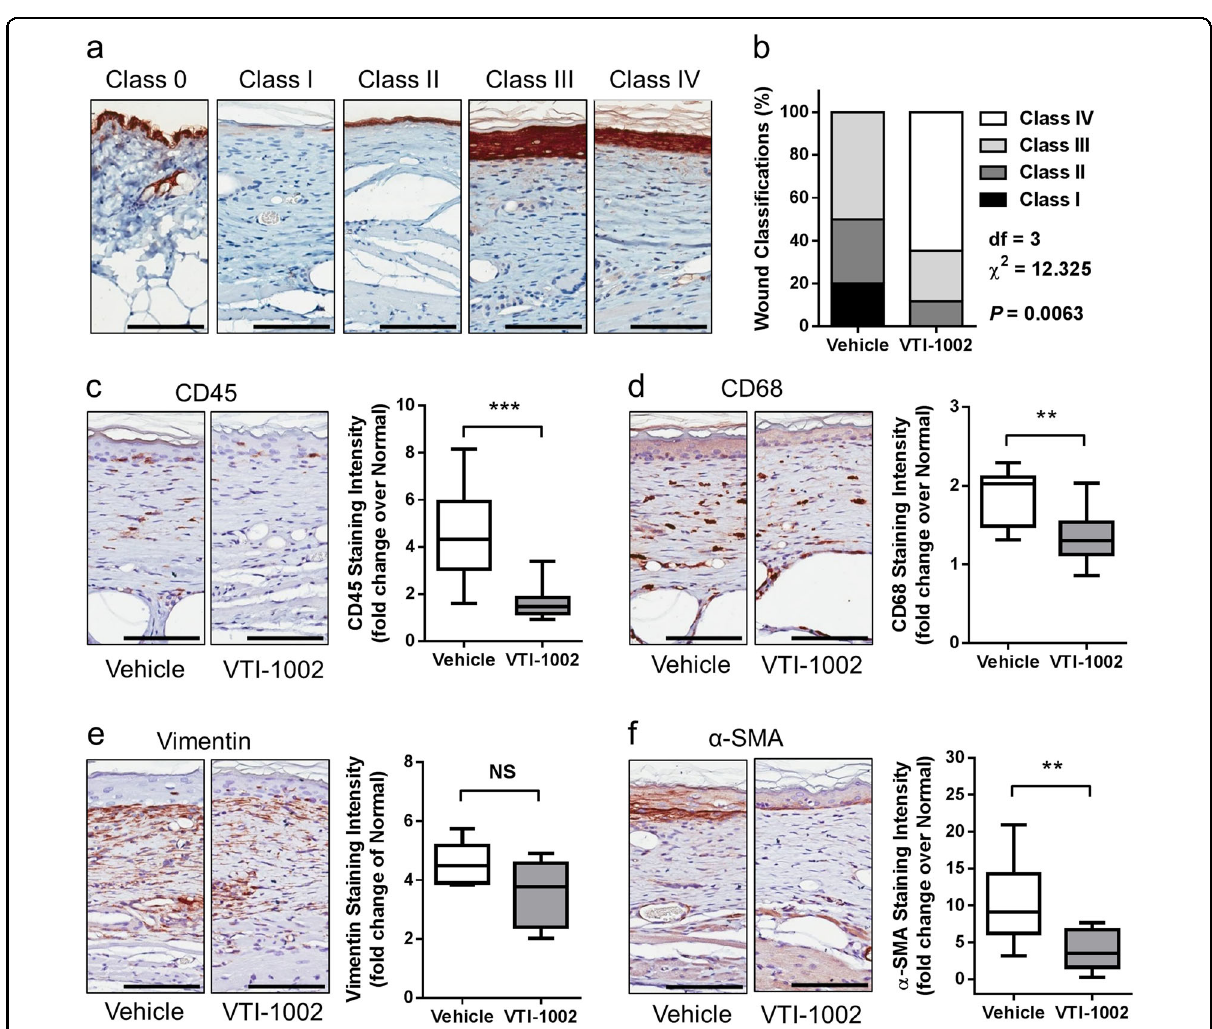
Fig. 2 Topical application of VTI-1002 gel accelerates re-epithelialization and wound maturation in diabetic burn wounds. a Representative morphology of different wound classes (IHC keratin staining). b Prevalence of wound class in vehicle control group ( n = 10) and VTI-1002 treatment group ( n = 17). P = 0.0063 by χ 2 test. Representative images of c CD45, d CD68, e vimentin, f α -SMA staining, and quanti fi cation of c CD45, d CD68, e Vimentin, f α -SMA staining intensity in the wounds at day 30 from vehicle control group and VTI-1002 treatment group ( n ≥ 5 per group). Results are expressed as median and min/max value, NS = not signi fi cant, ** P < 0.01, *** P < 0.001 by Student's t test. Scale bar = 100